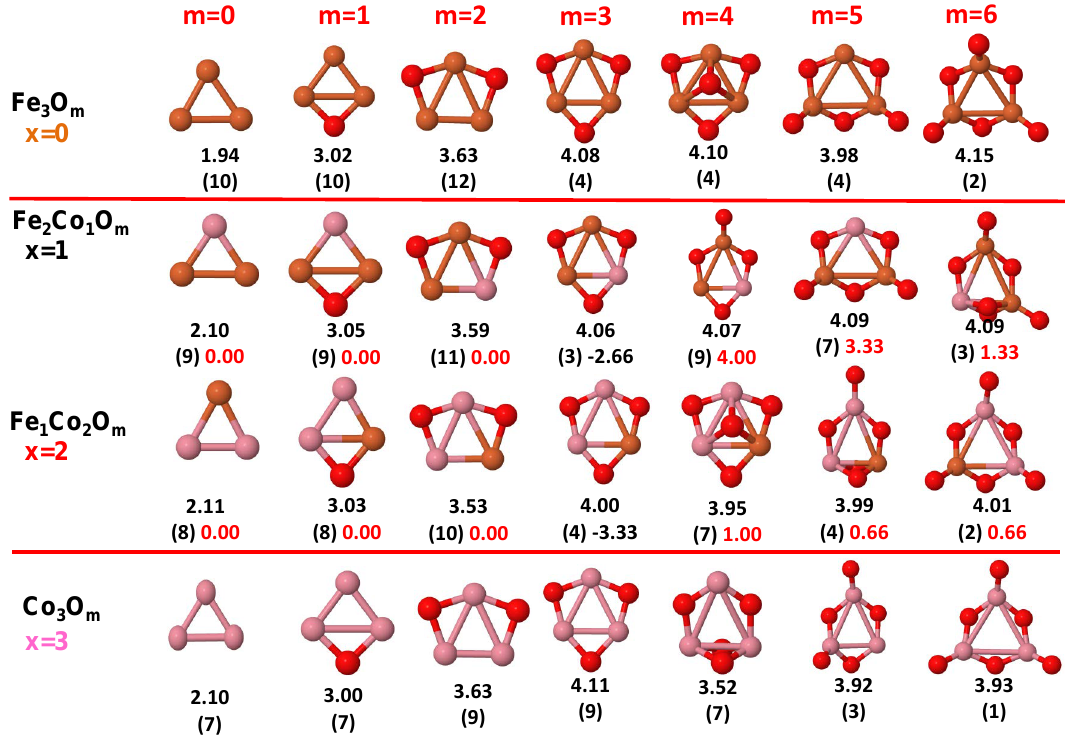
Figure 4. Putative global minimum structures of Fe 3 − x Co x O m , x = 0–2, m = 1–6. Numbers below structures are the binding energy per atom (in eV), numbers in parentheses are the magnetic moment (in µ B ) and the third number (when present) is the excess magnetic moment (in µ B ) defined in Equation (2). Fe atoms in brown color, Co atoms in pink and oxygen atoms in